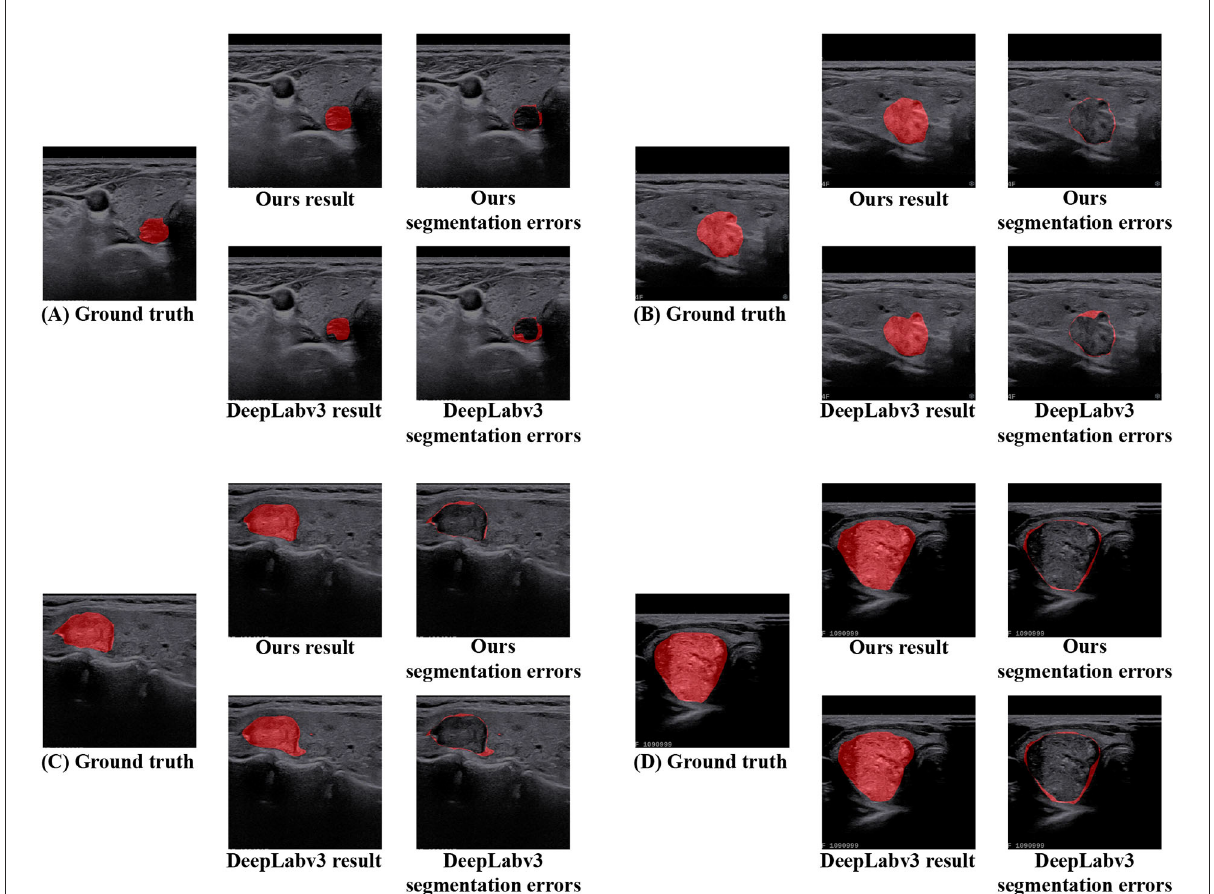
FIGURE7 The segmentation area and error of DeepLabV3 and our N-Net methods are further visualized on the TNUI-2021 dataset. (A–D) Ground truth, ours result, ours segmentation errors, DeepLabv3 result, and DeepLabv3 segmentation